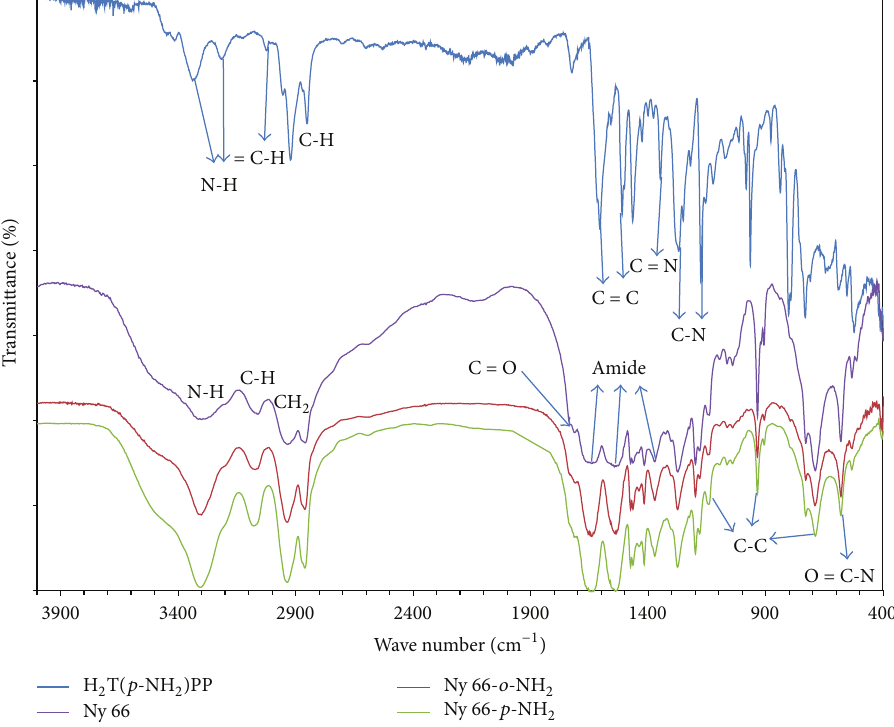
Figure 8: FTIR spectra of pure Nylon 66 (blank) and of Ny 66- o -NH 2 and Ny 66- p -NH 2 hybrid species as compared with the FTIR spectrum of the H 2 T( p -NH 2 )PP free base.